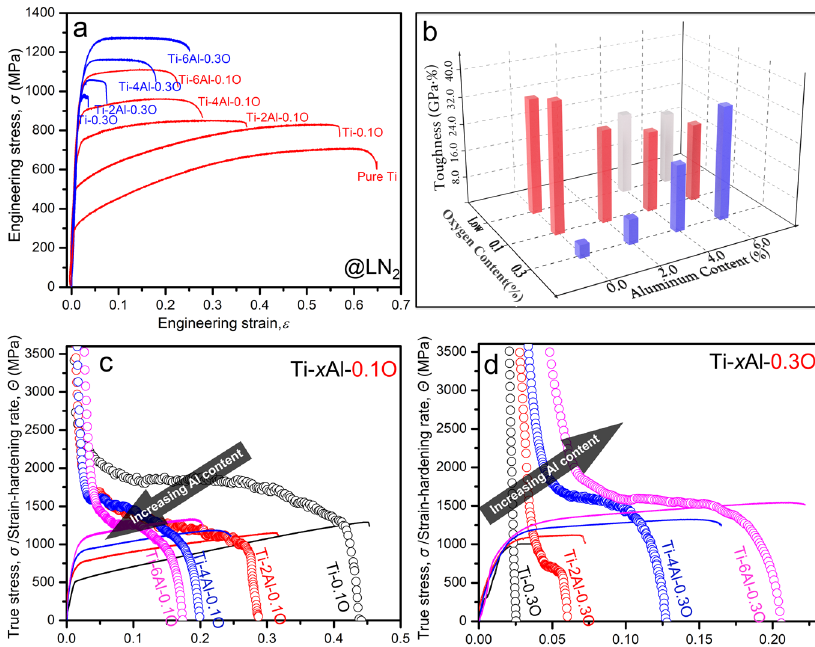
Fig. 1 Mechanical properties of Ti-Al-O ternary alloys at liquid nitrogen temperature. a Engineering stress – strain curves of Ti-O and Ti-Al-O alloys tested in liquid nitrogen at a strain rate of 10 − 3 s − 1 (all compositions in wt.%). b 3D-plot showing the combined effects of aluminum and oxygen contents on the tensile toughness (the area covered beneath the engineering stress – strain curves) of Ti-O and Ti-Al-O alloys in liquid nitrogen. True stress – strain curves (solid lines) and strain-hardening rate curves (symbols) of Ti- x Al-0.1 O c and Ti- x Al-0.3O d alloy systems ( x = 0, 2, 4, and 6) in liquid nitrogen. The strain-hardening rates and tensile ductilities of the two alloy systems trend in opposite directions with increasing aluminum